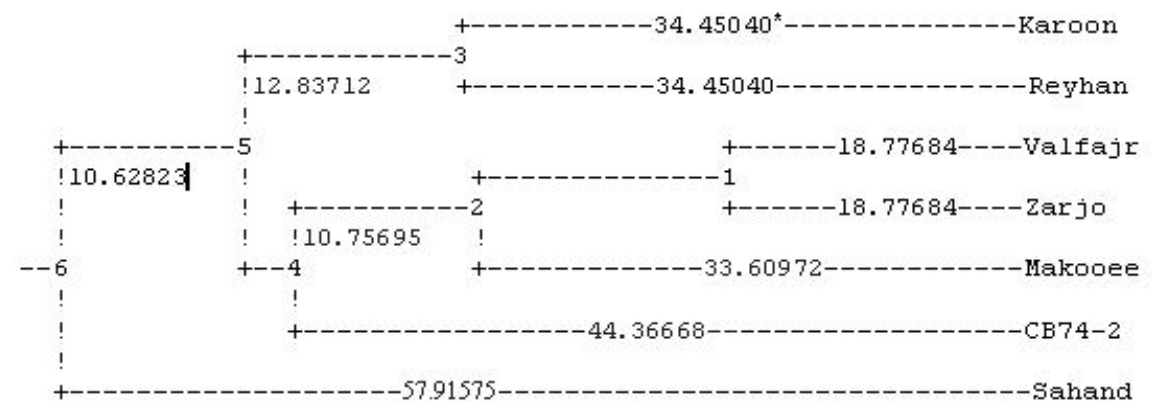
Fig. 2. Dendrogram based Nei’s (1972) genetic distance among populations of barley by Popgen 32. *Distances between